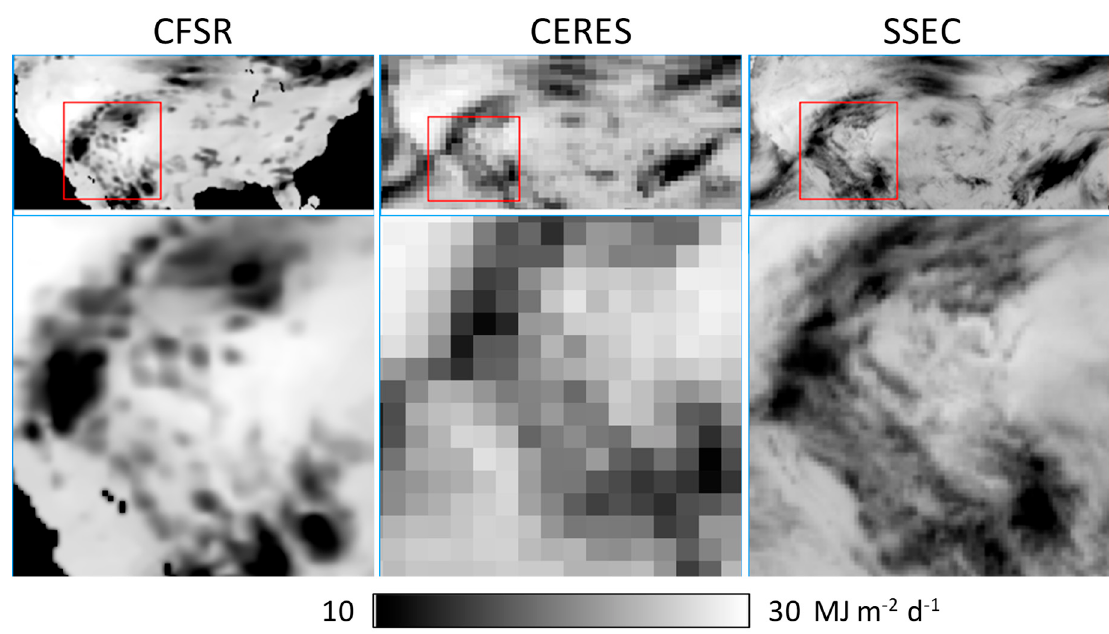
Figure 3. Comparison of daily insolation maps for 2017 DOY 200 from the CFSR, CERES, and SSEC products. A zoom in over the southwestern U.S. is included to highlight differences in structure and resolution between the products.